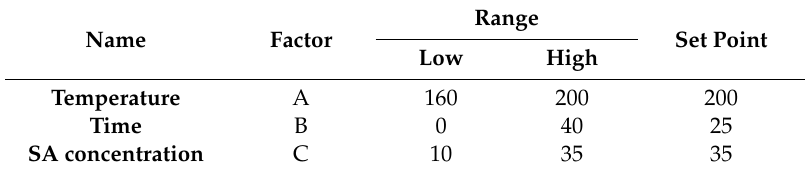
Table 5. Optimal conditions (set point) for maximized HHV predicted by the RSM polynomial